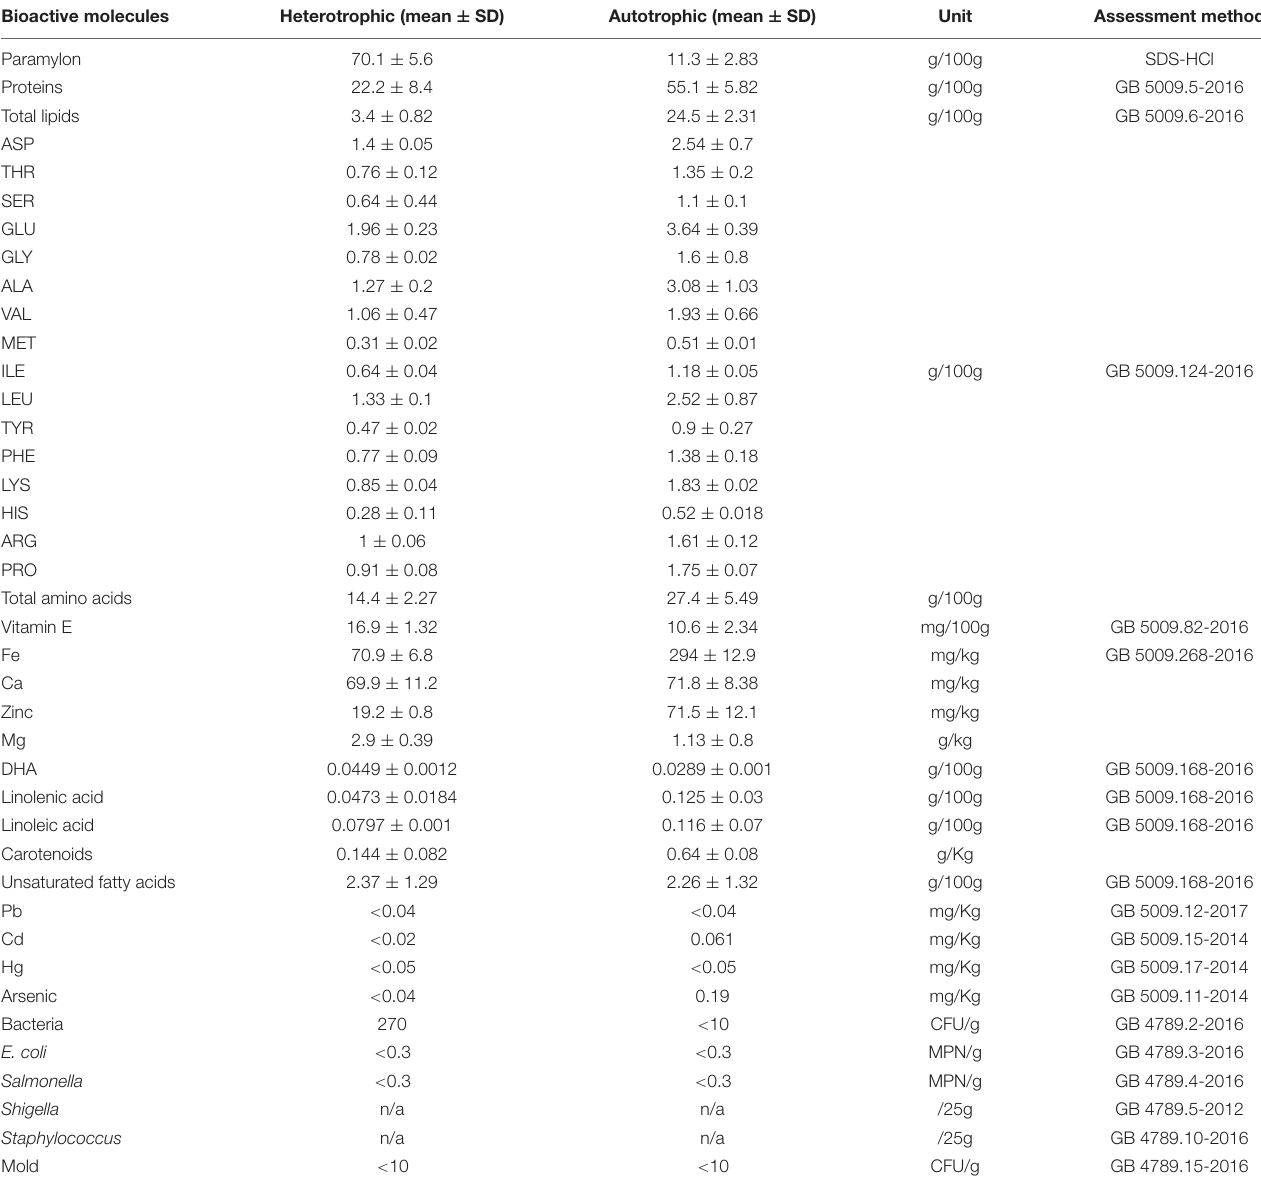
TABLE 1 | Nutrient contents in different Euglena powders, AE and HE as auto- and heterotrophic Euglena ,